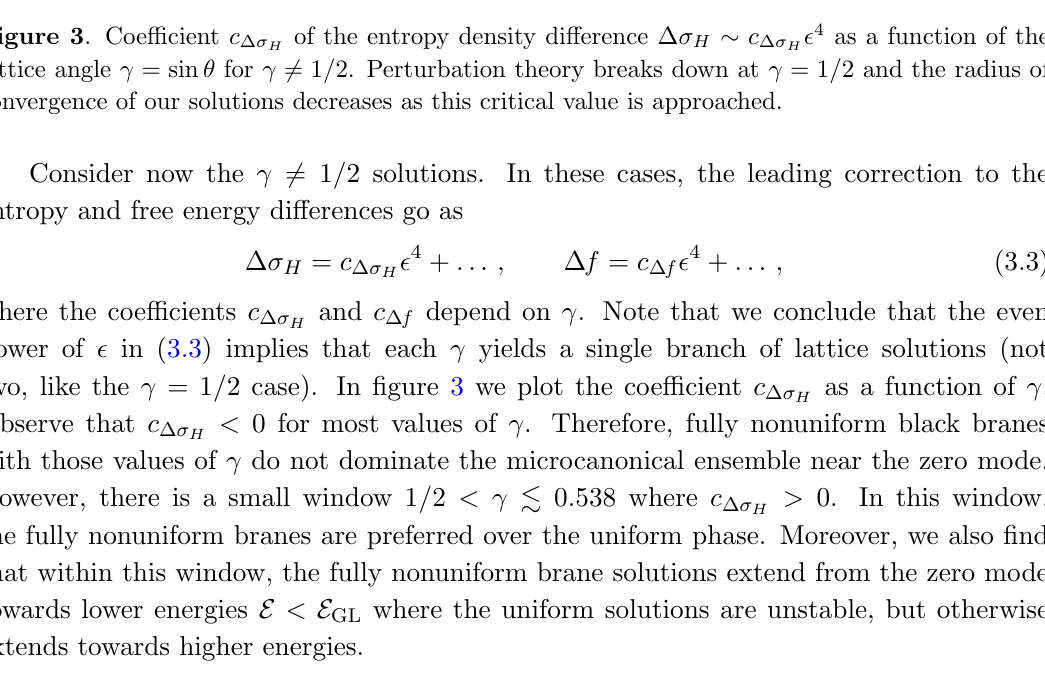
(cid:15) 4 as a function of the H